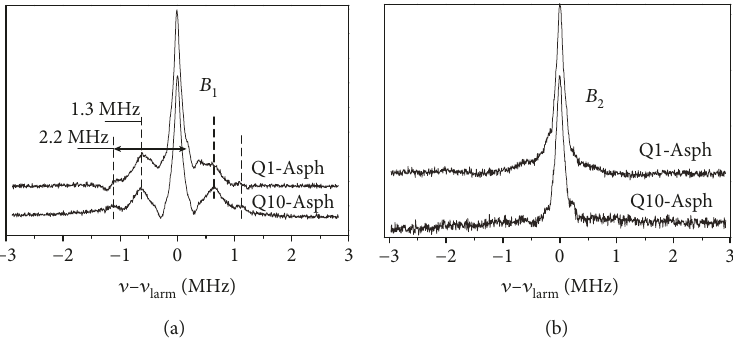
Figure 8: 1 H di ff erence ENDOR spectra for samples Q1 and Q10 measured at (a) B